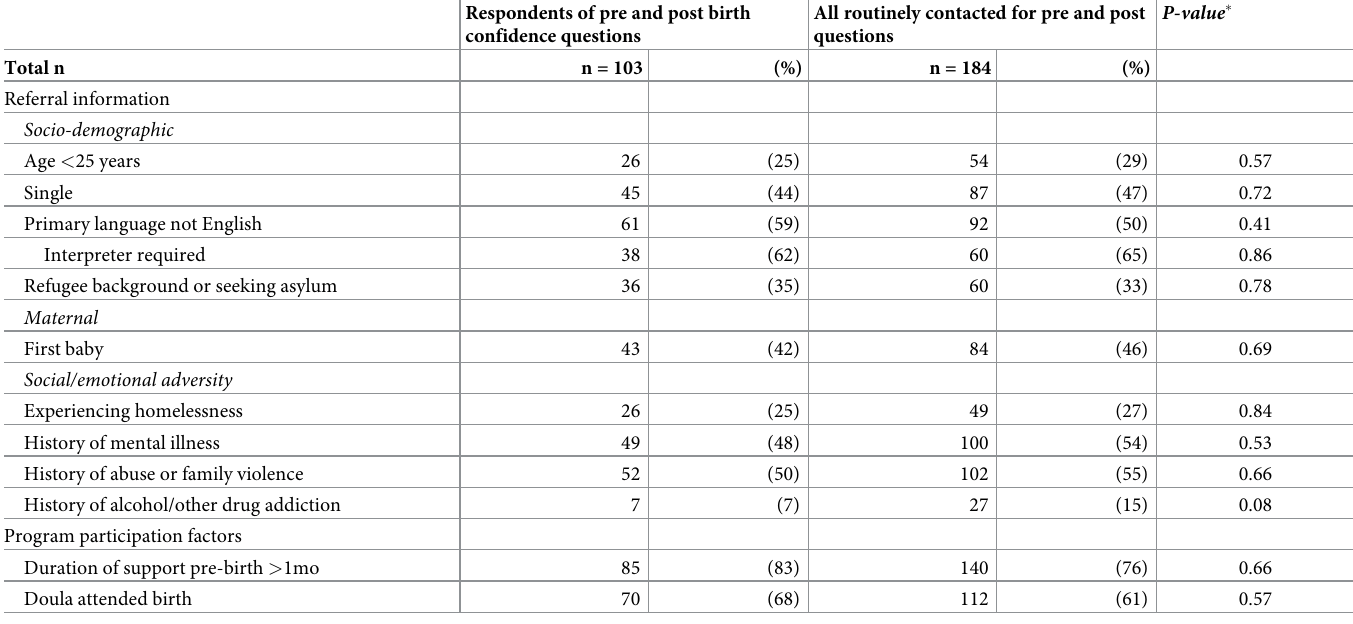
Table 3. Sociodemographic, maternal, social/emotional, and program participation characteristics of respondent group vs all women routinely asked pre and post questions. Respondents of pre and post birth confidence